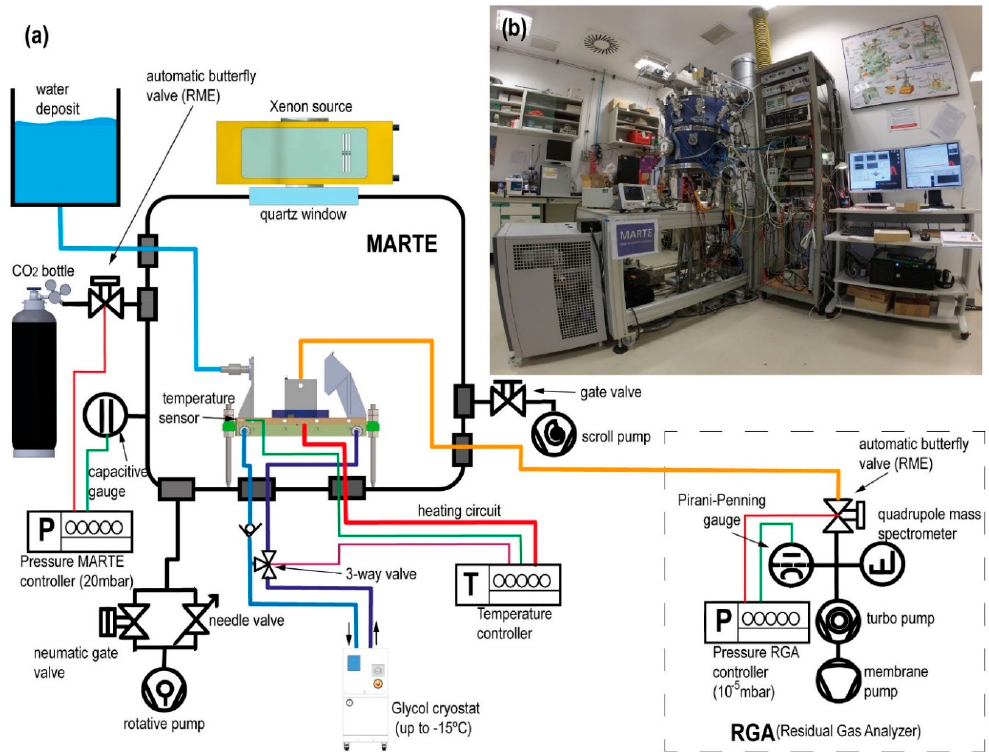
Figure 2. ( a ) Technical illustration of the MARTE simulation system (sample holder temperature control, gas composition, and pressure control). ( b ) Photograph of the MARTE simulation system.